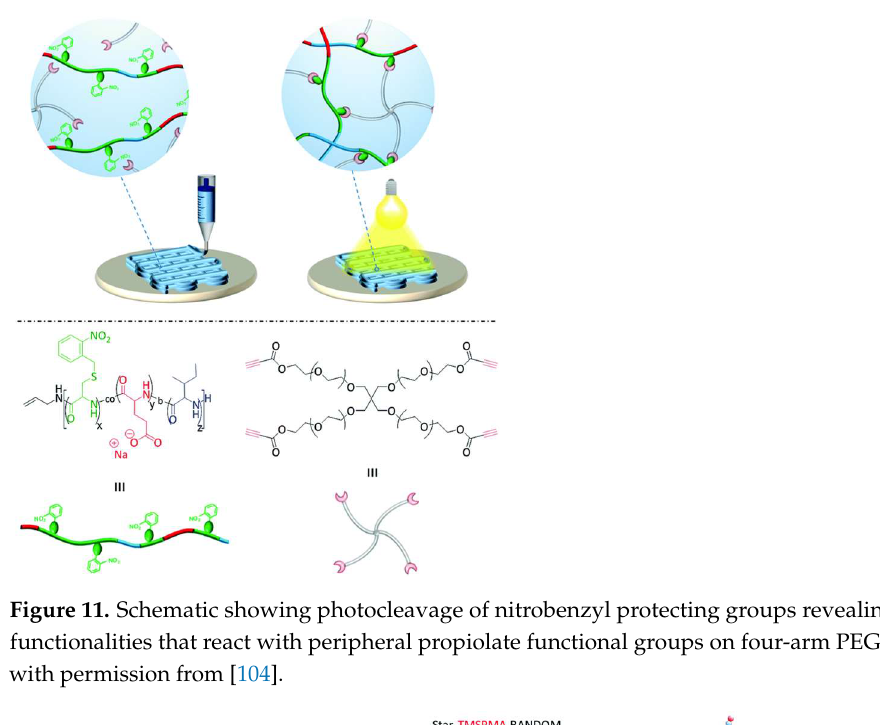
Figure 11. Schematic showing photocleavage of nitrobenzyl protecting groups revealing free thiol functionalities that react with peripheral propiolate functional groups on four-arm PEG. Reprinted with permission from [104].